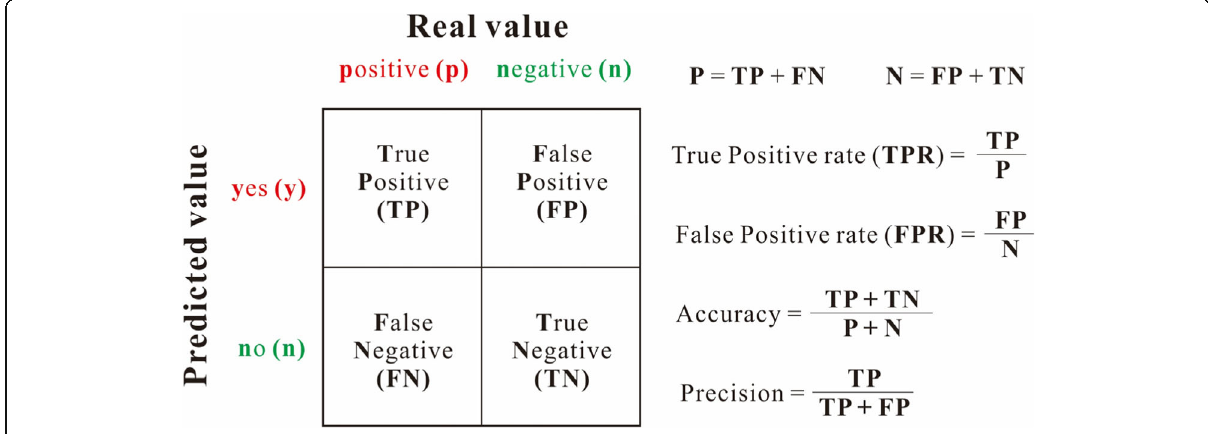
Fig. 12 Schematic diagram of the confusion matrix (modified from Fawcett